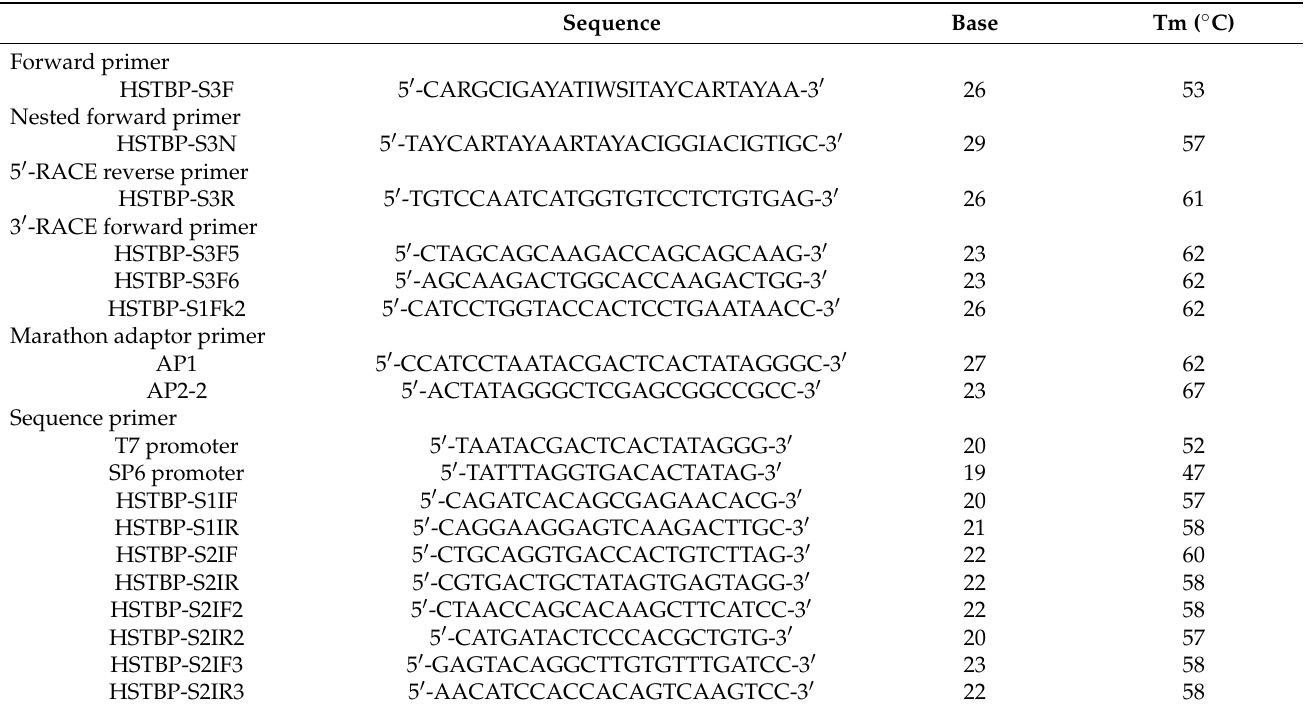
Table 2. Primers used in this study. ⇒ Need space between “Base” and “Tm ( C )”. Sequence Base Tm ( ◦